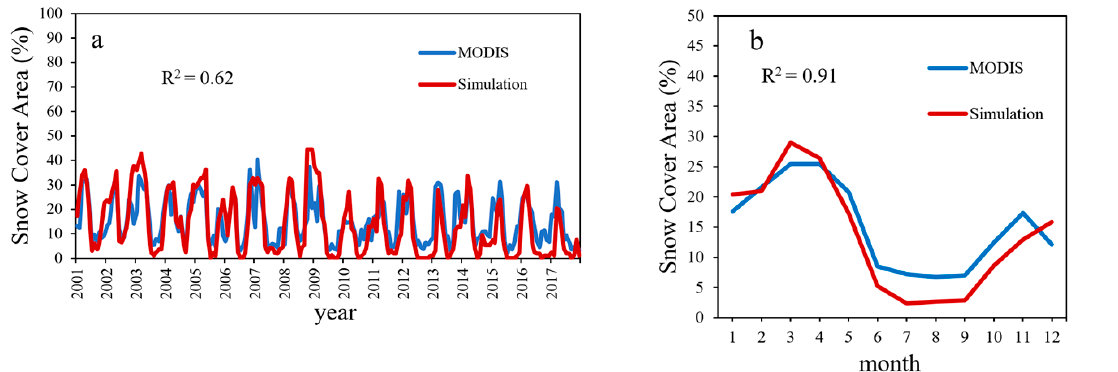
Figure 2. Simulated and observed (MODIS) for ( a ) monthly and ( b ) multi-year monthly average snow cover area of the study area during 2001–2017.